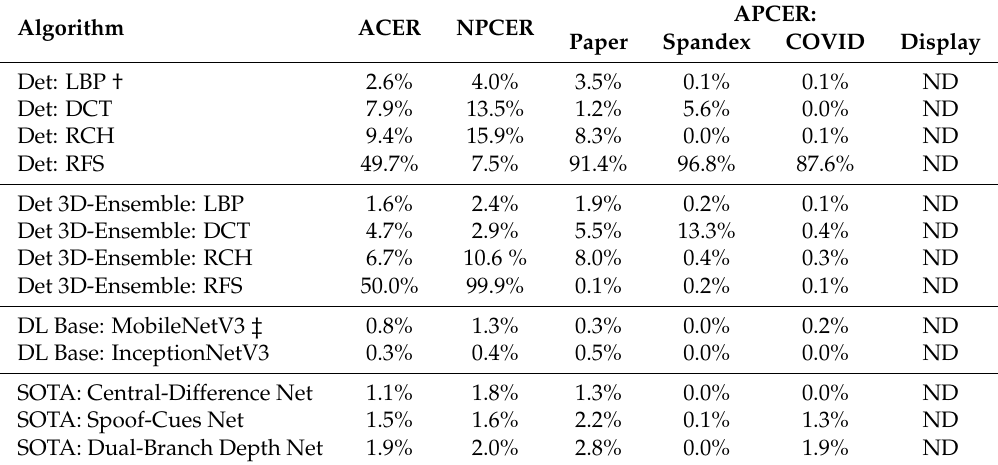
Table 3. Facial presentation–attack–detection experiment results: lab and exterior sun conditions. † indicates optimal deterministic algorithm. ‡ indicates optimal deep learning